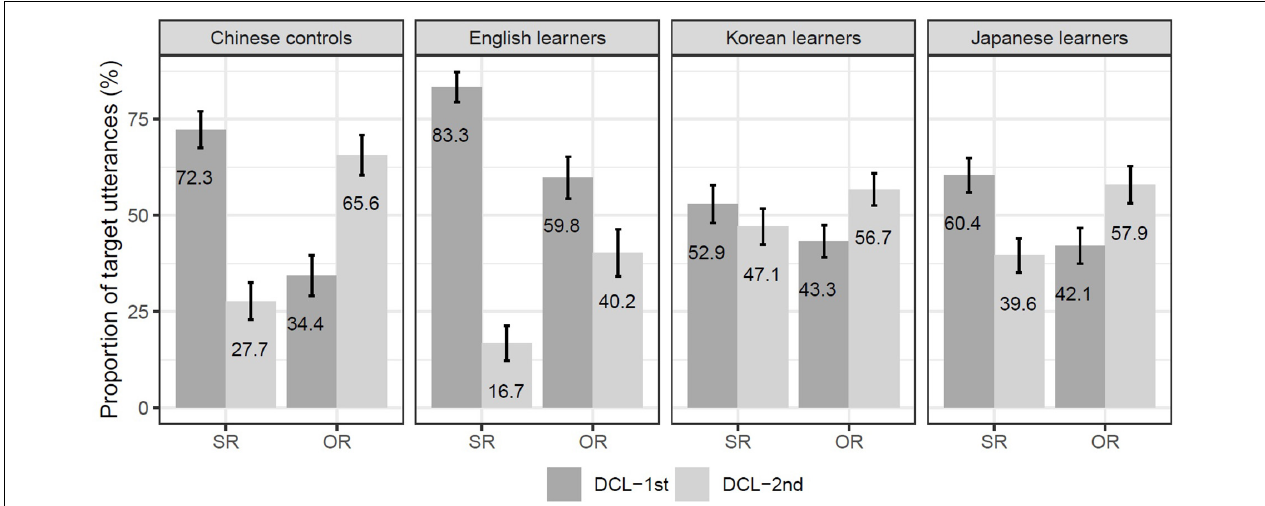
FIGURE 3 | The distribution of DCL in SR and OR across Chinese controls and three L2 groups. Error bars are standard errors over by-participant means.